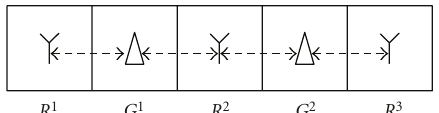
Figure 6: An example of tra ffi c scheduling in backbone communi-